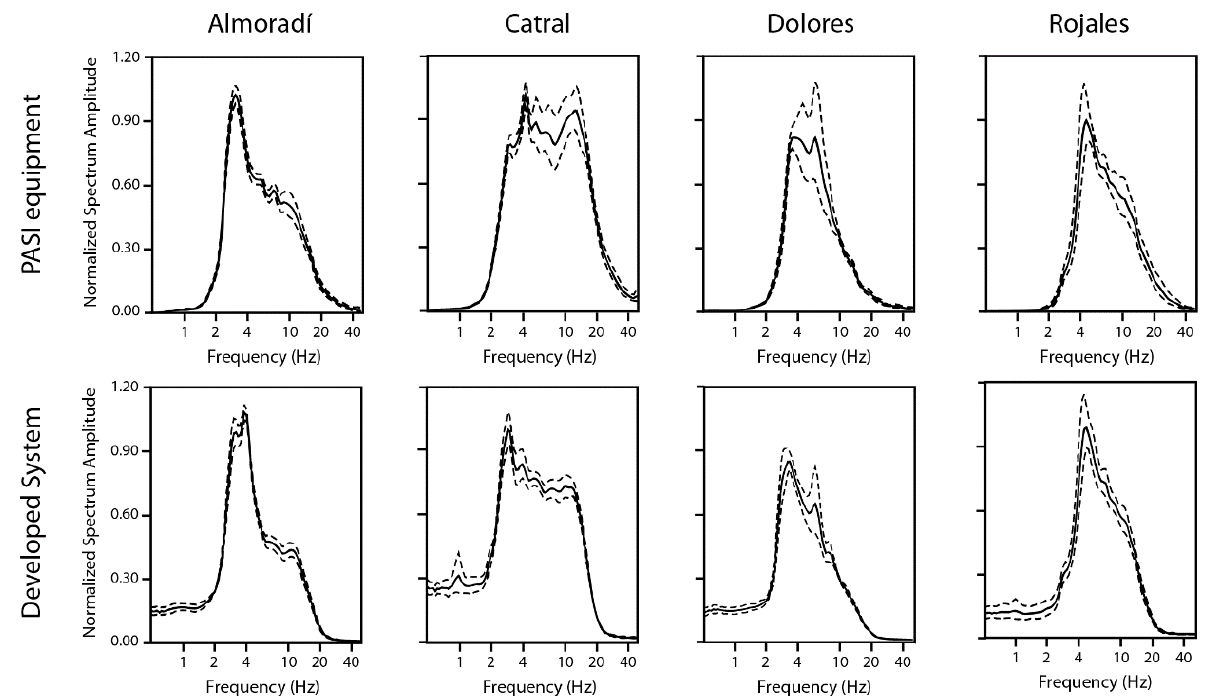
Figure 12. Normalized spectrum amplitude for the different analyzed sites, using P.A.S.I equipment and the developed system. The continuous black line indicates the mean value, and the dashed lines are the mean value ± standard deviation, respectively.